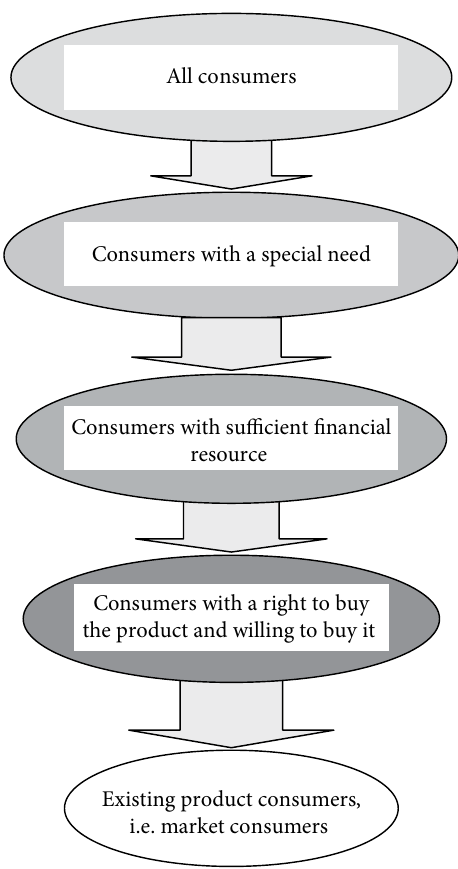
Existing product consumers, i.e. market Fig. 1. Levels of potential consumers